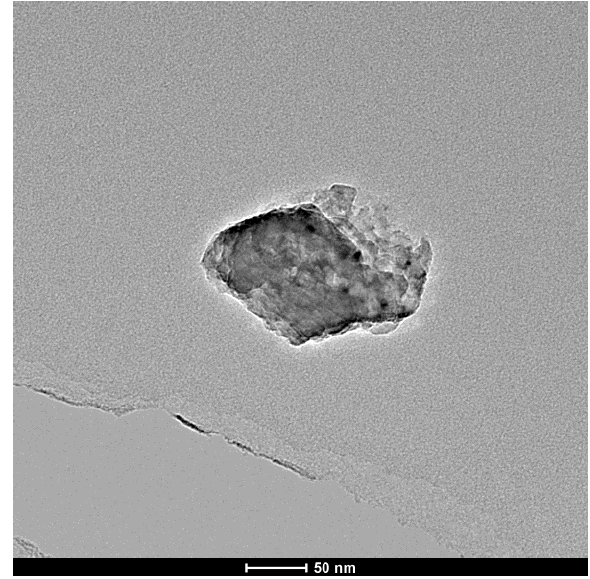
Figure 16. TEM image of an O-, S-, Fe-, Co-, and Ca-containing particle from a deep-seated fault gouge in the Dongshengmiao de-